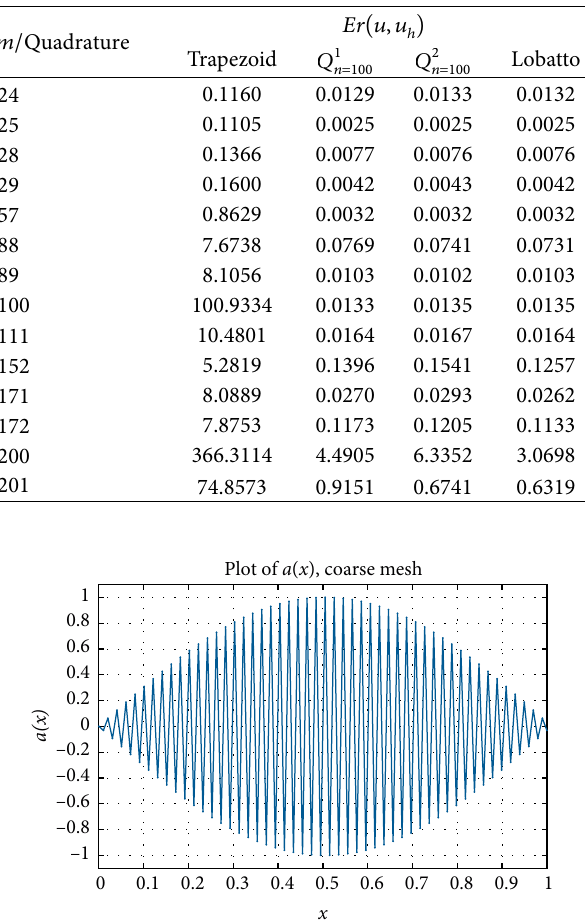
Table 1: Numerical results for the example 1 with different values . of 𝑚